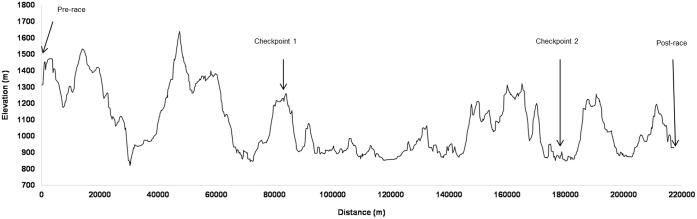
Elevation profile throughout the “Brazil 135 Ultramarathon” route with the four session test locations. Reprinted and adapted minimally from Belli et al. (2017b), Copyright (2017), with permission from Elsevier.